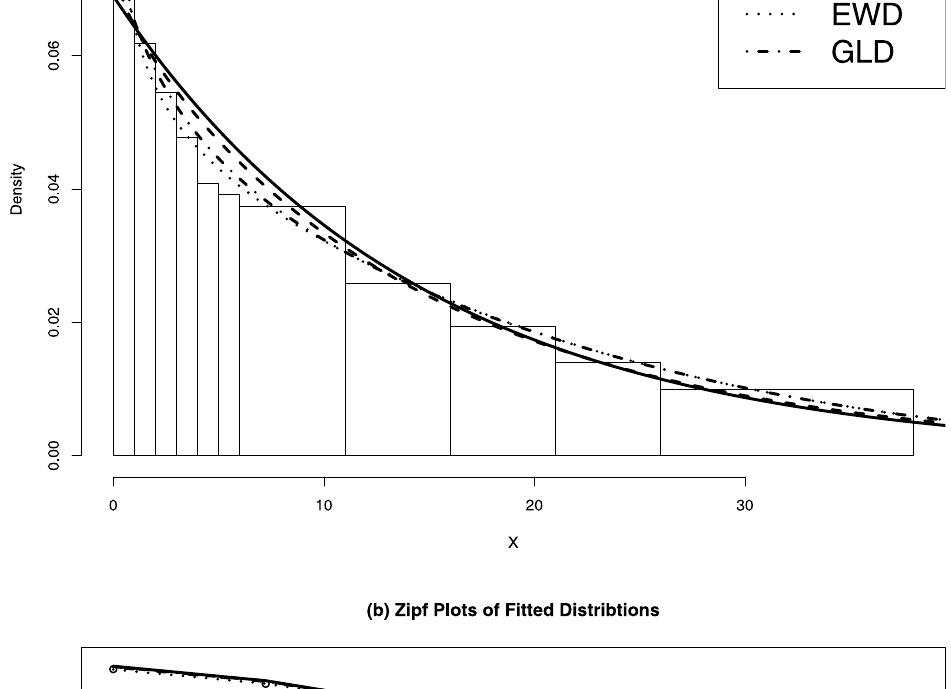
Fig 2. Fitted distribution to 2014 US private-sector firm age data. Left panel: estimated density functions. Right panel: Zipf plots of the fitted distributions.